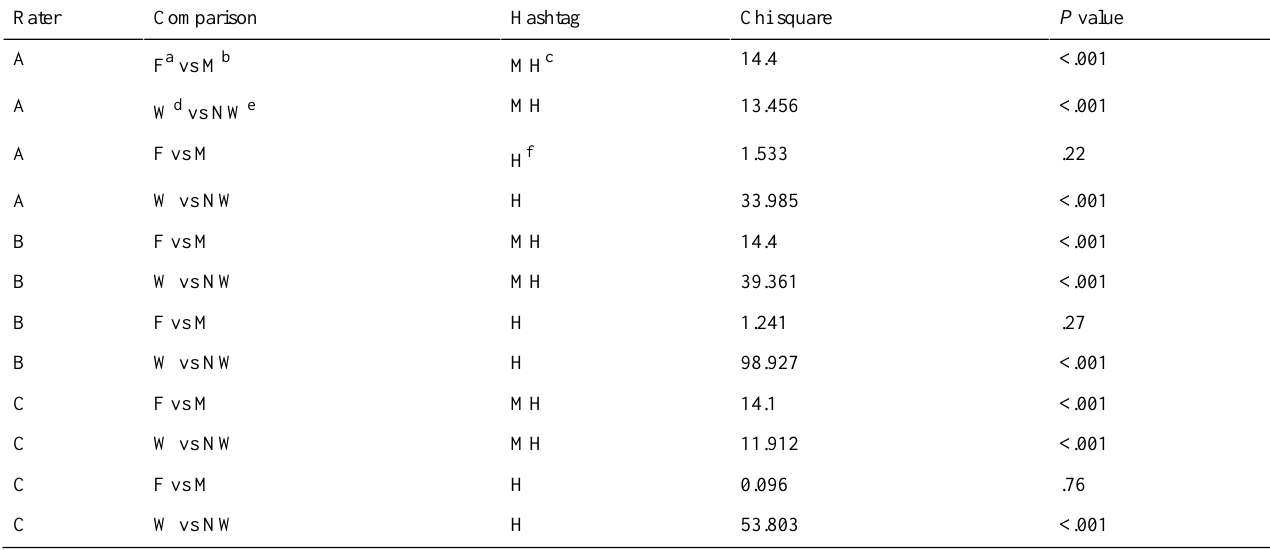
Table 3. Chi-square analyses by rater, comparison, and hashtag.